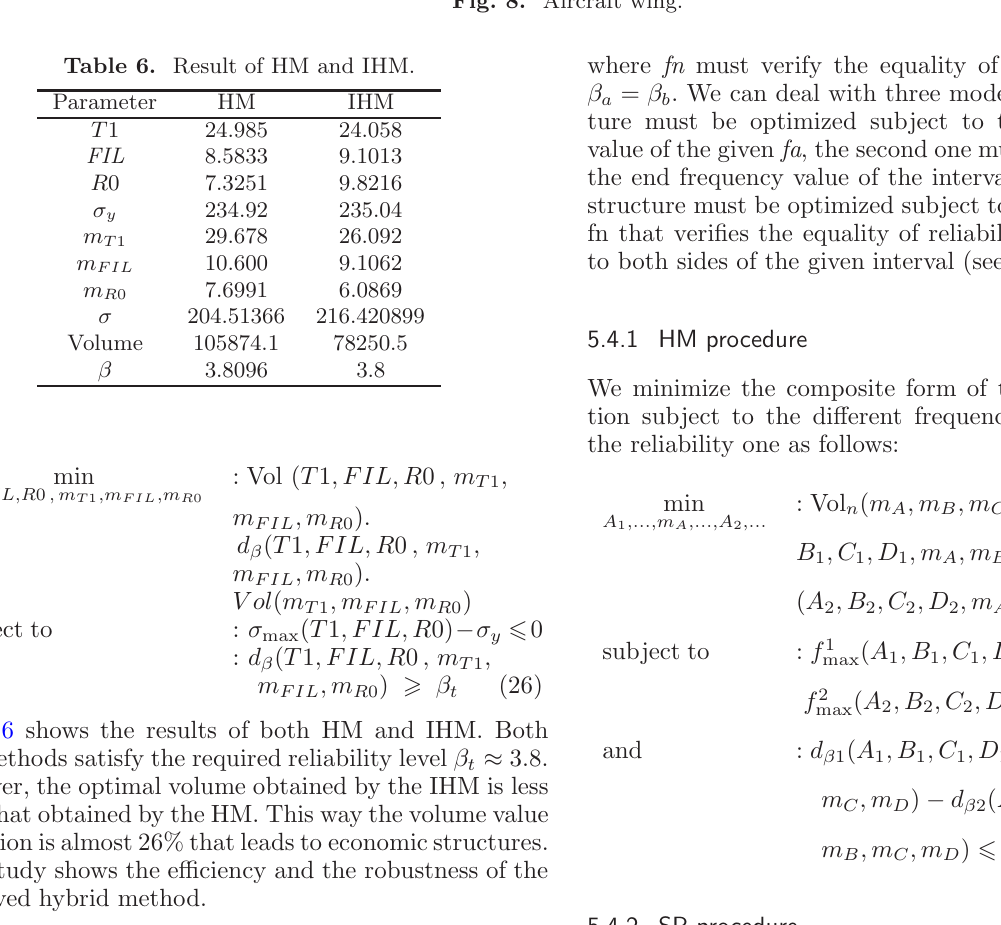
Fig. 8. Aircraft wing.